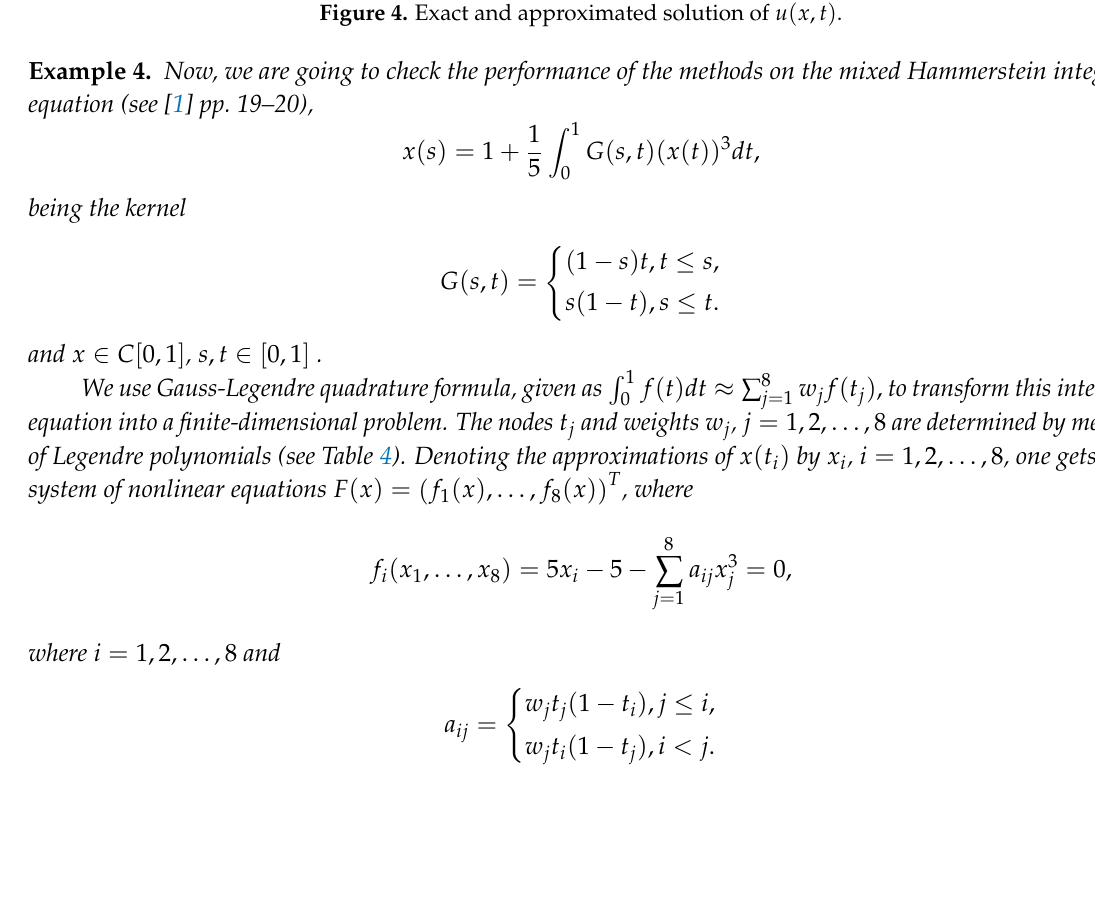
Figure 4. Exact and approximated solution of u ( x , t )